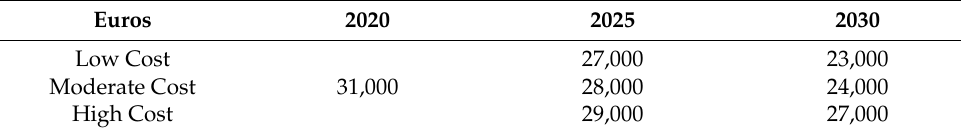
Table 5. Assumptions on the evolution of medium sized EVs purchasing cost (in euros).